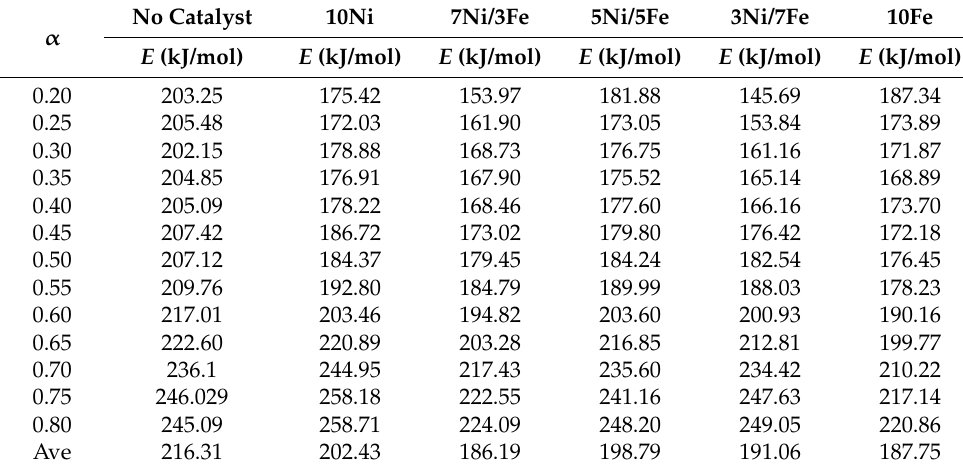
Table 4 lists the activation energies and methods presented in the open